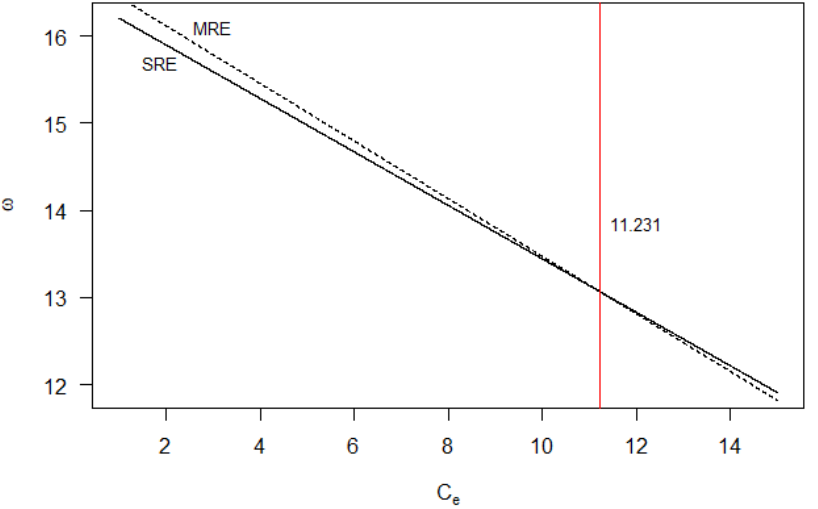
Figure 2. Limiting profit per unit time as a function of C e for system with S = 2 and RF =